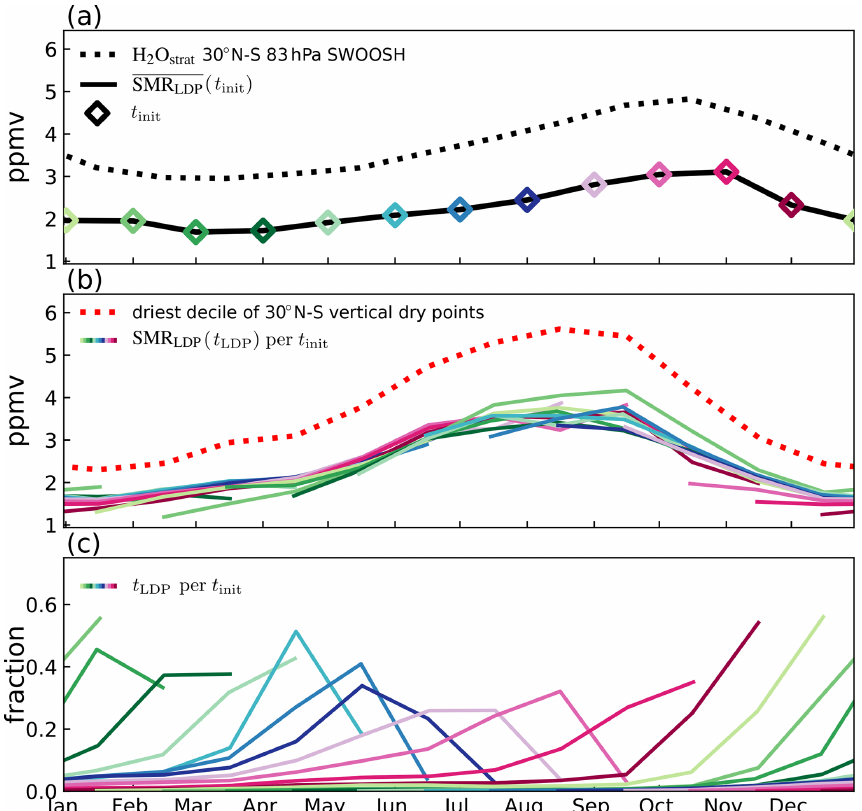
Figure 4. (a) Zonal mean tropical (30 ◦ N–30 ◦ S) mean 1999–2009 mean annual cycle of water vapour at 83hPa from SWOOSH observations (dotted) and ERA-Interim LDP estimates (black line) with coloured diamonds denoting initialisation dates. (b) Estimates of water vapour concentration at final dehydration location, LDPs (coloured line for each release date, t init ) and an Eulerian estimate from the driest decile of tropical vertical profiles of saturation mixing ratio (red dotted line). (c) Fractional contribution of LDP events to SMR LDP estimate in each month for each initialisation date ( t init ) (colours as in a ). Akin to Fig. 6 of Fueglistaler et al. (2013) but showing predicted concentrations from trajectories released within 30 ◦ N–30 ◦ S monthly, as well as observations and an additional Eulerian estimate of water vapour. See Sect. 3.2 for